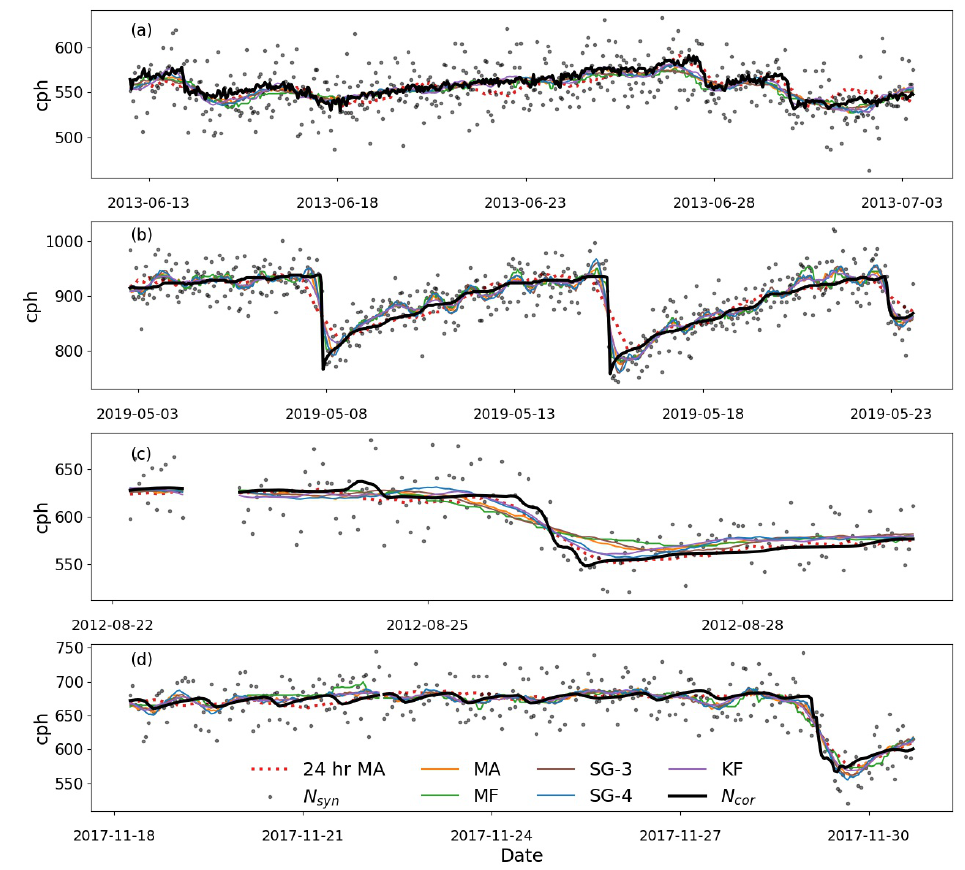
Figure 6. Time series of synthetic neutron flux (gray dot) and filtered flux using the MF, MA, SG and KF filtering techniques at SMEAR II ( a ), Gorigo ( b ), Rollesbroich ( c ) and Conde ( d ) sites. The black line represented the original neutron